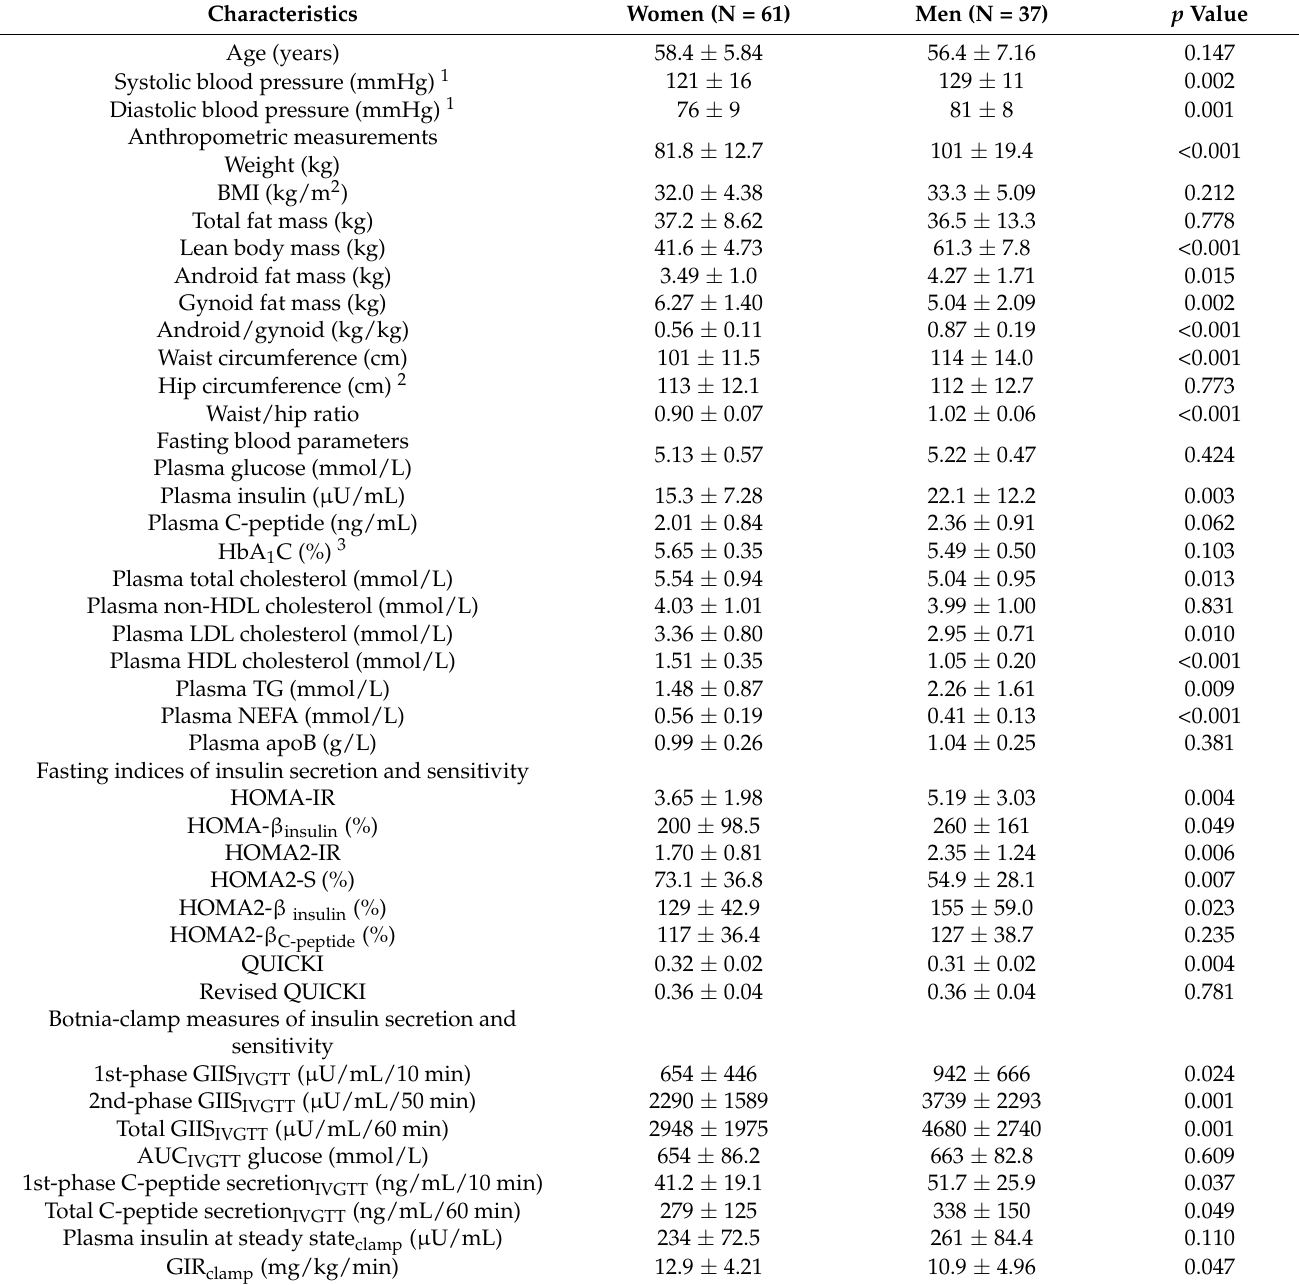
Table 1. Baseline anthropometric and plasma parameters as well as fasting and Botnia-clamp mea- sures of insulin secretion and sensitivity in the study